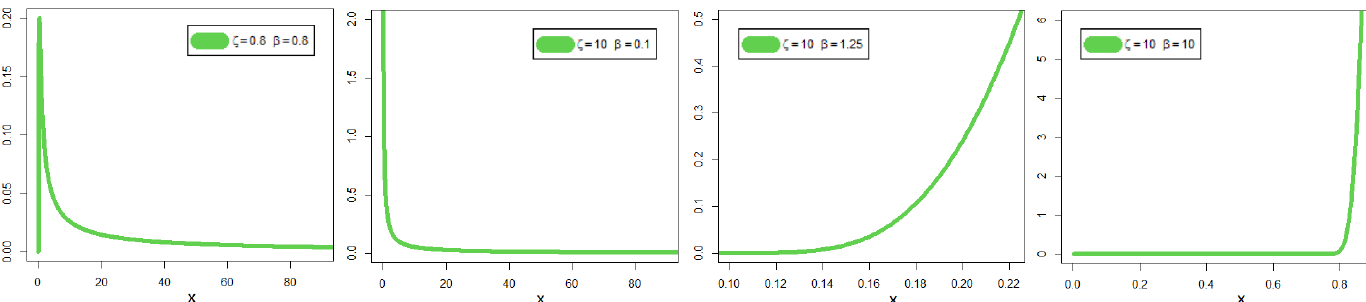
Figure 2: Plots of the HRF for selected parameter